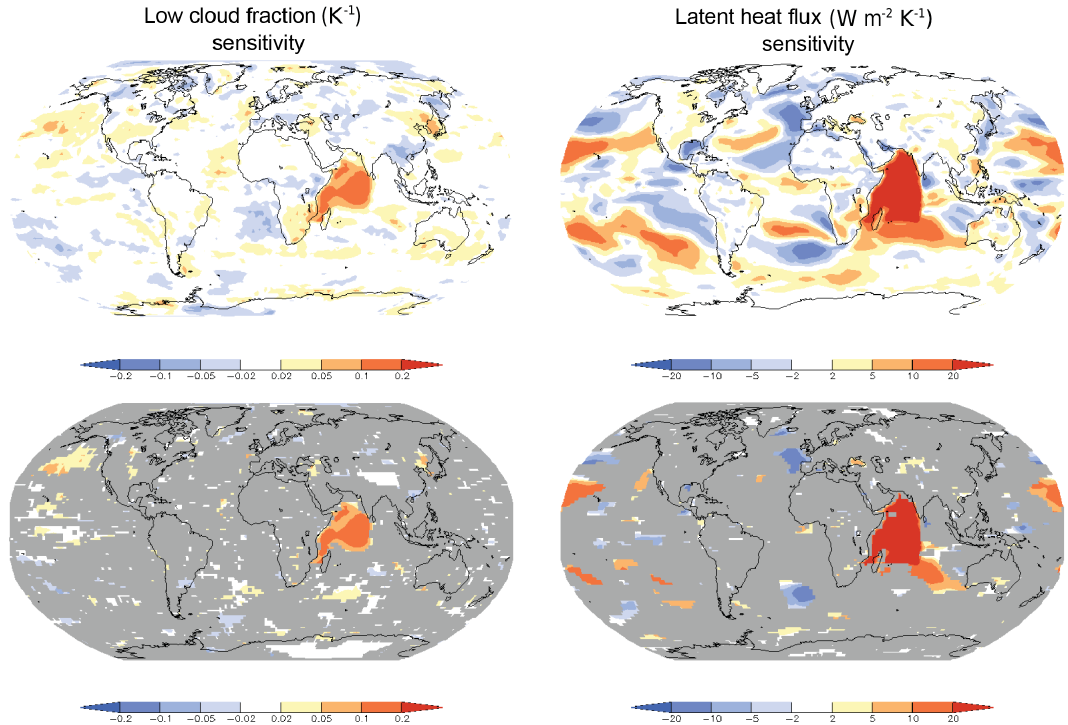
Figure 10. Top row shows sensitivities calculated by projection over the entire 7300-day simulation (repeated from the middle panels of Fig. 5). Bottom panels show the same values but masked out (grey) where they are not statistically significant at the 95% confidence level (two-sample unpaired Student’s t test) as calculated from the standard deviation values presented in Fig.